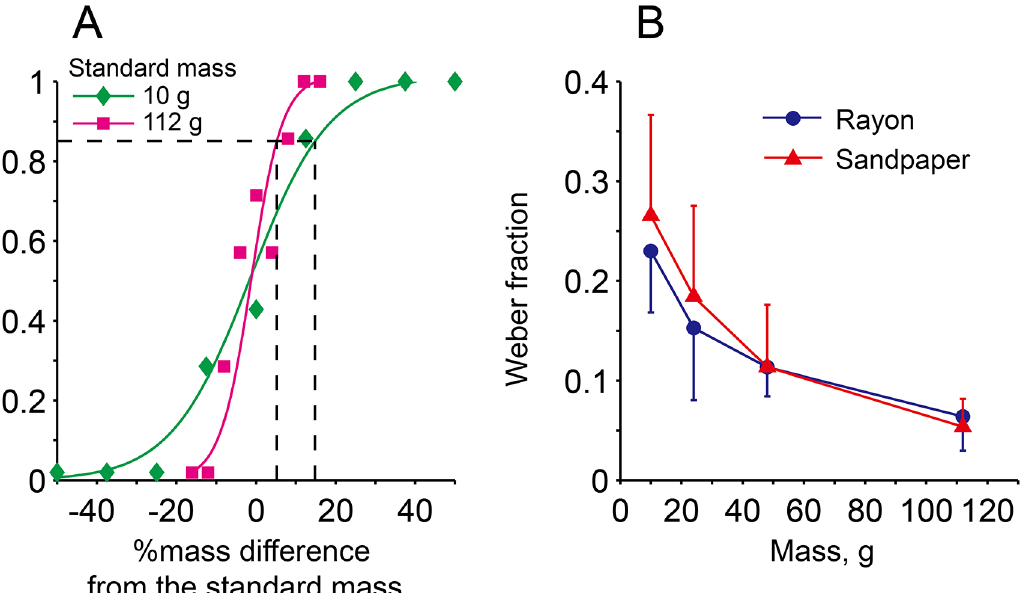
Fig 5. A typical example of the mean probability of correct response in relation to percent difference in test mass from the standard masses of 10 and 112 g for the rayon surface in one subject (A). Logistic function curves were fitted to examine their relationship. Changes in mean Weber's fraction with test mass for all subjects for the rayon and sandpaper surfaces (B). The vertical bars indicate the standard deviation